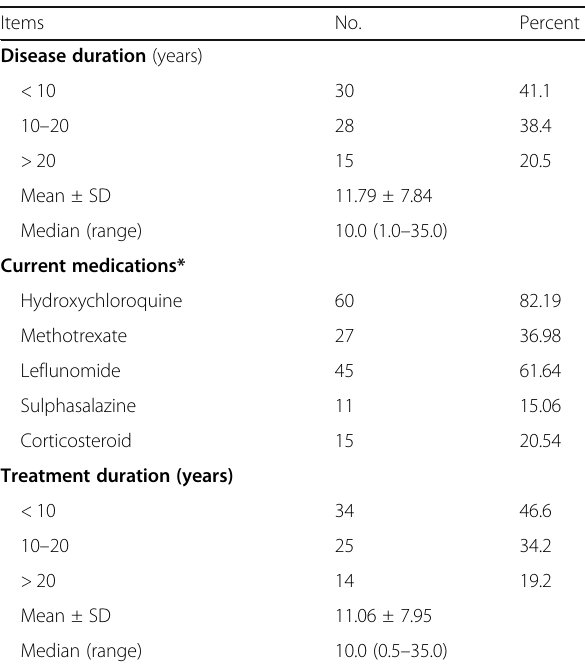
Table 2 Distribution of studied patients according to their disease duration, current medication, and treatment duration